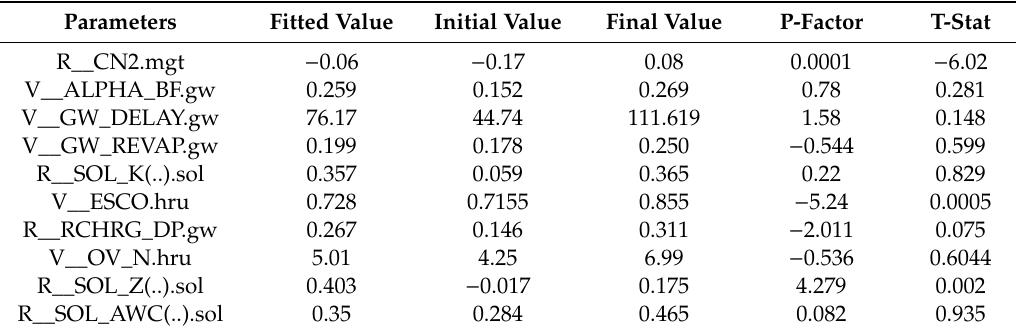
Table 5. Fitted, initial, and final values of optimized parameters.